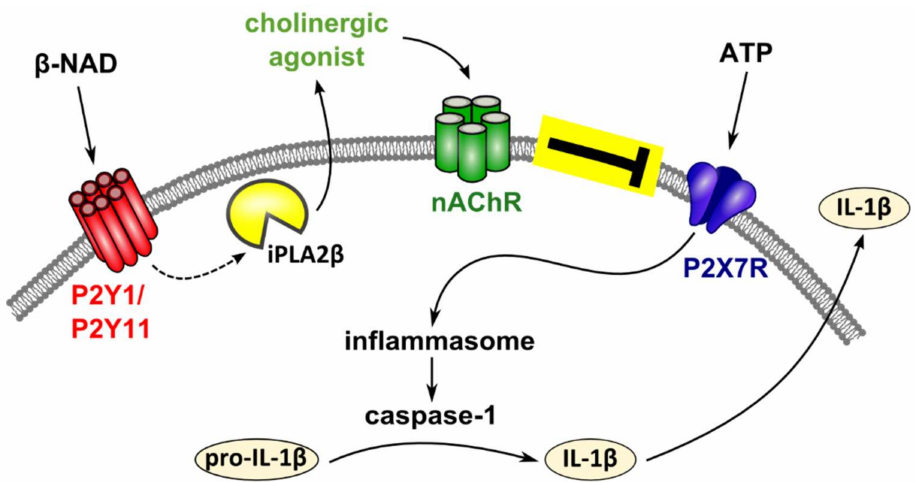
Figure 8. Schematic presentation of the proposed mechanism. Extracellular β -NAD and ATP are spilled concomitantly from damaged cells. ATP binds to the ATP-sensitive P2X7 receptor of monocytic cells, induces inflammasome activation, activation of caspase-1, cleavage of pro-IL-1 β and release of bioactive IL-1 β . Our data suggest that β -NAD signals via P2Y receptors that activate iPLA2 β and result in the production and secretion of yet unidentified bioactive mediators. These mediators seem to function as nicotinic agonists that activate non-canonical metabotropic functions at nicotinic acetylcholine receptors. Nicotinic receptor stimulation, in turn, efficiently inhibits the ion-channel function of the P2X7 receptor. It is unclear, if nicotinic receptors subunits actually form conventional pentamers as shown in the schematic